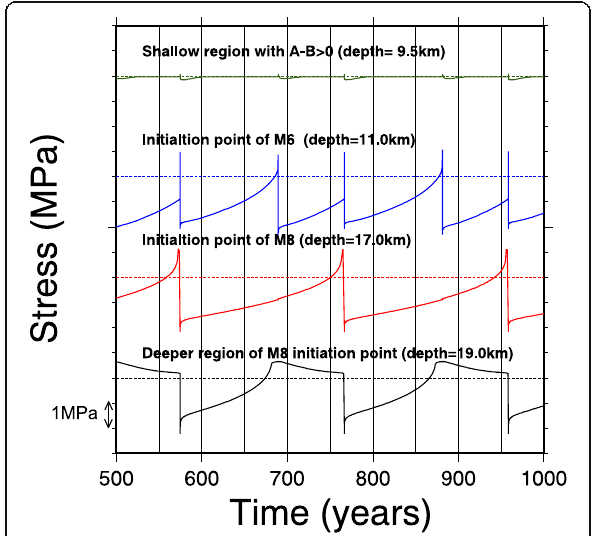
Fig. 8 Temporal changes in shear stress on the plate interface. The same time interval as Fig. 7a at the four depths are shown. The blue and red lines represent shear stress profiles at the initiation points of M6 (depth of 11 km) and M8 earthquakes (depth of 17 km), respectively. At depths deeper than the hypocenter of the M8 earthquake (black line), the stress accumulation rate is higher than that at the hypocenter because of secular loading from stable sliding occurring at a region deeper than the hyper-asperity. At depths shallower than the hyper-asperity (green lines), shear stress is almost constant because of stable sliding, except during the postseismic periods of M6 and M8 earthquakes. Dashed lines represent the reference stress level of each line, with corresponding